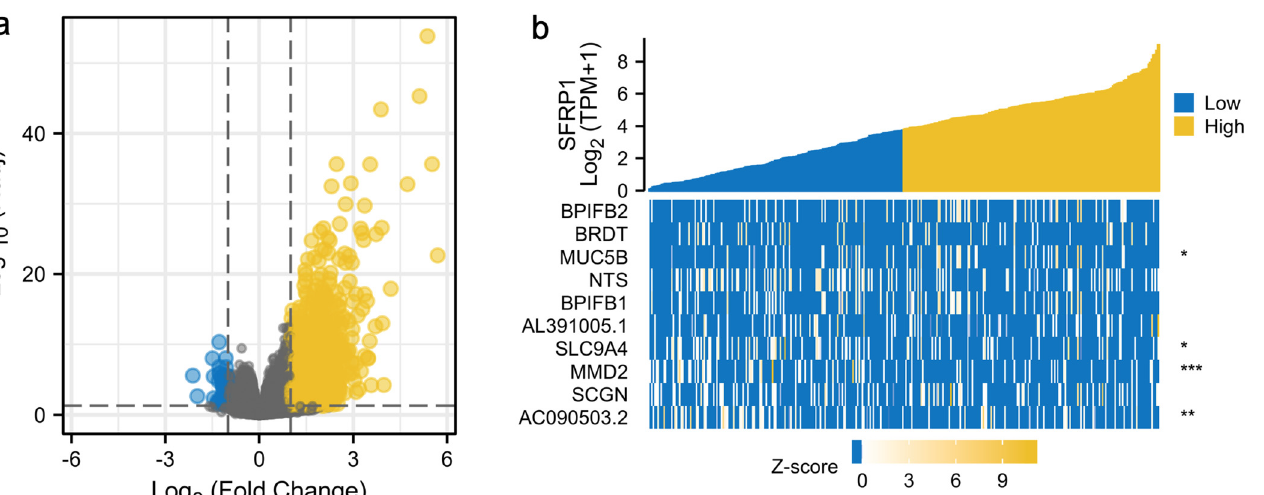
Figure 7. Protein–protein interaction (PPI) network and functional enrichment analysis. ( a ) PPI net- work of SFRP1 and co-expressed genes; ( b ) GO terms in the “biological process (BP)” category; ( c )